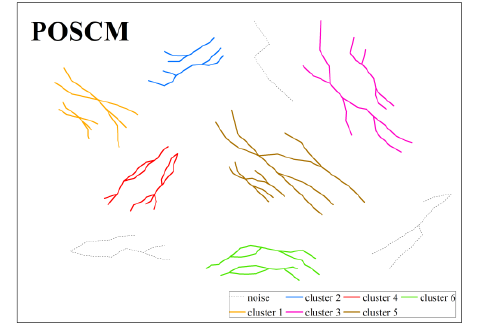
Figure 5. Clustering results of POSCM based on structural and spatial similarity.